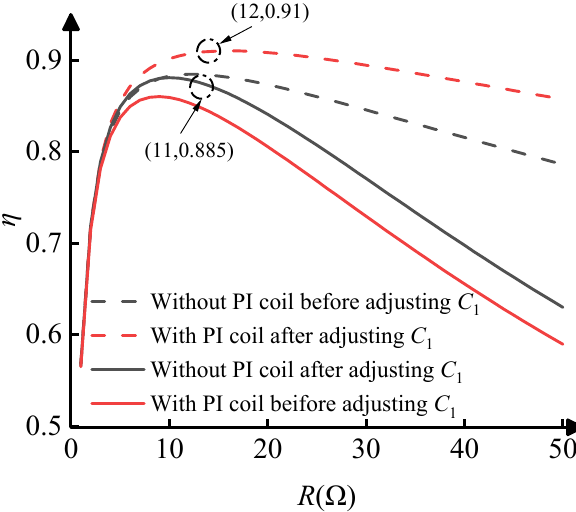
Figure 14. Power transfer efficiency varying with load.